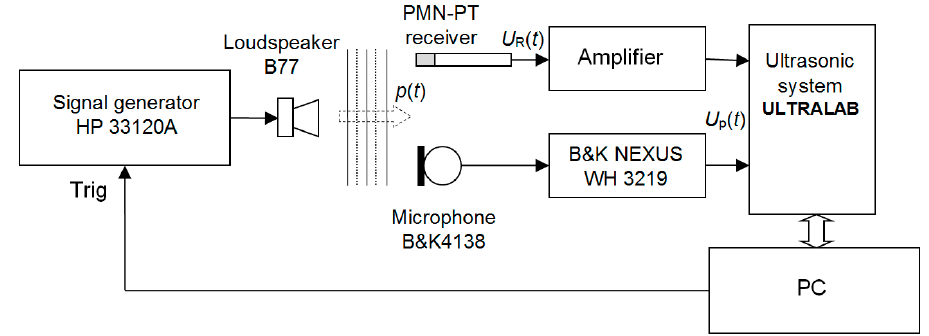
Figure 13. Schematic diagram of the experimental set-up for investigation of the PMN-PT receiver.